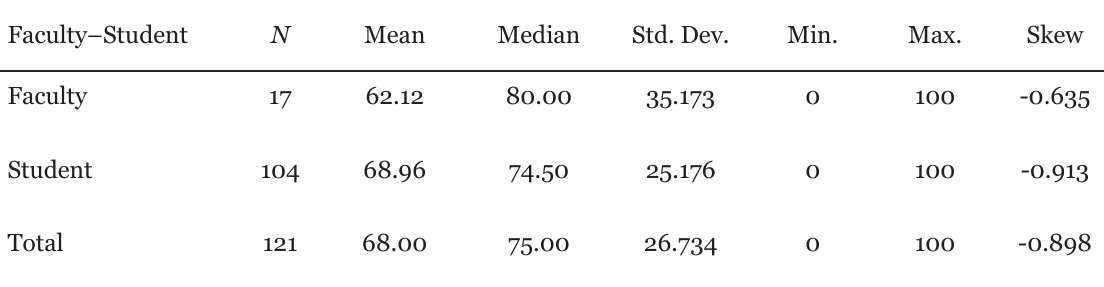
Self-Efficacy Scores: Faculty–Student Comparison